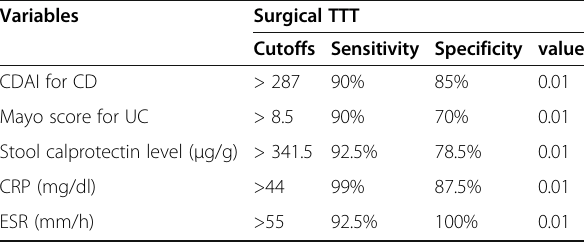
Table 3 Cutoff values of different scores and inflammatory markers in prediction of surgical intervention in IBD patients Variables Surgical